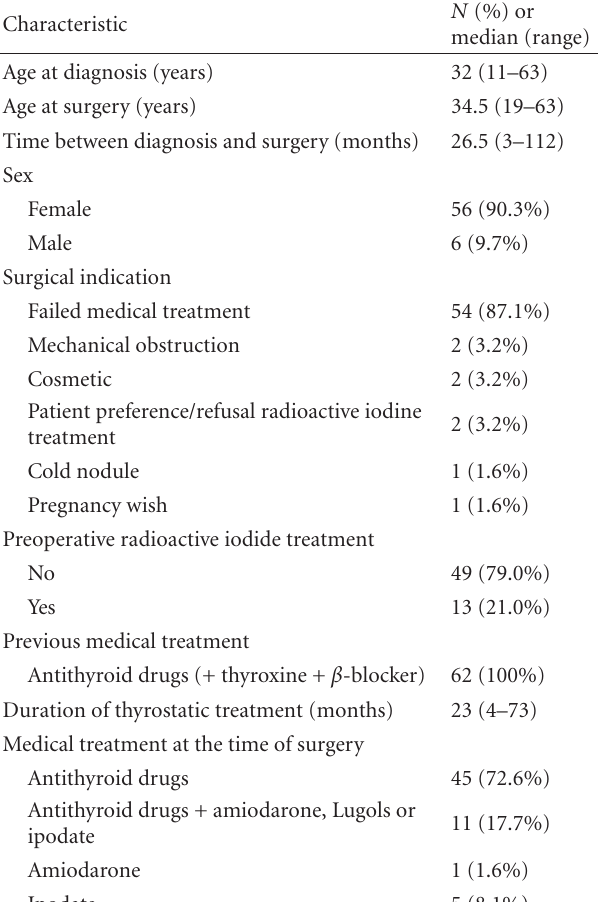
Table 1: Patient